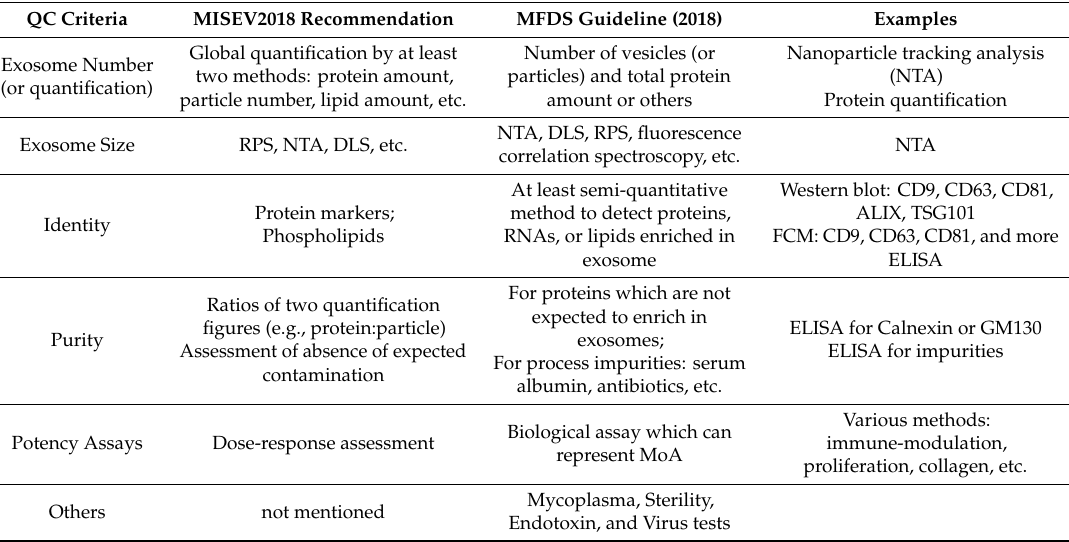
Table 1. Comparison of Minimal Information for Studies of Extracellular Vesicles 2018 (MISEV2018) and the Korea Ministry of Food and Drug Safety (MFDS) Guideline.